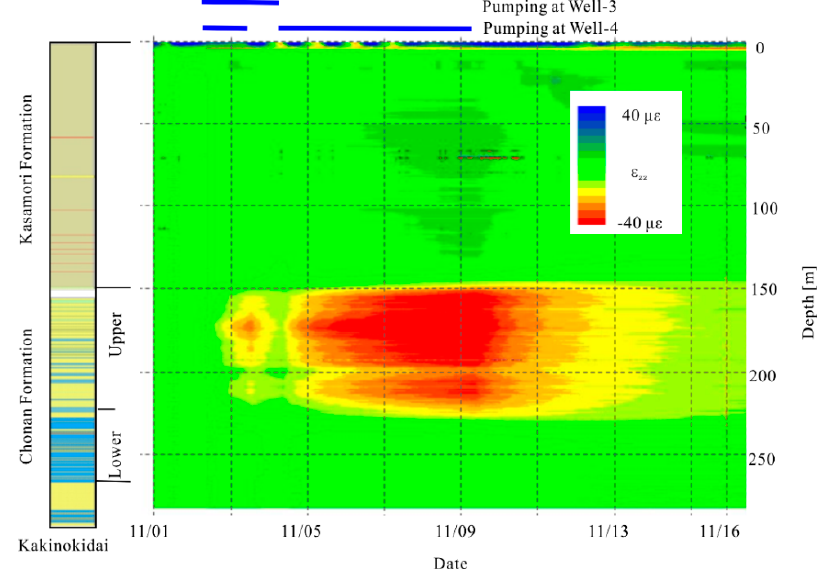
Figure 4. Pumping history and vertical strain observed by the fiber sensor. The spatial and temporal sampling intervals are 5 cm and 5 min,